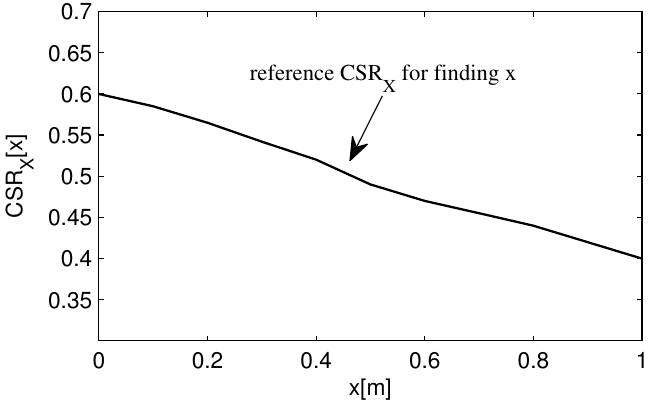
Figure 4. Reference correlation sum ratio for finding